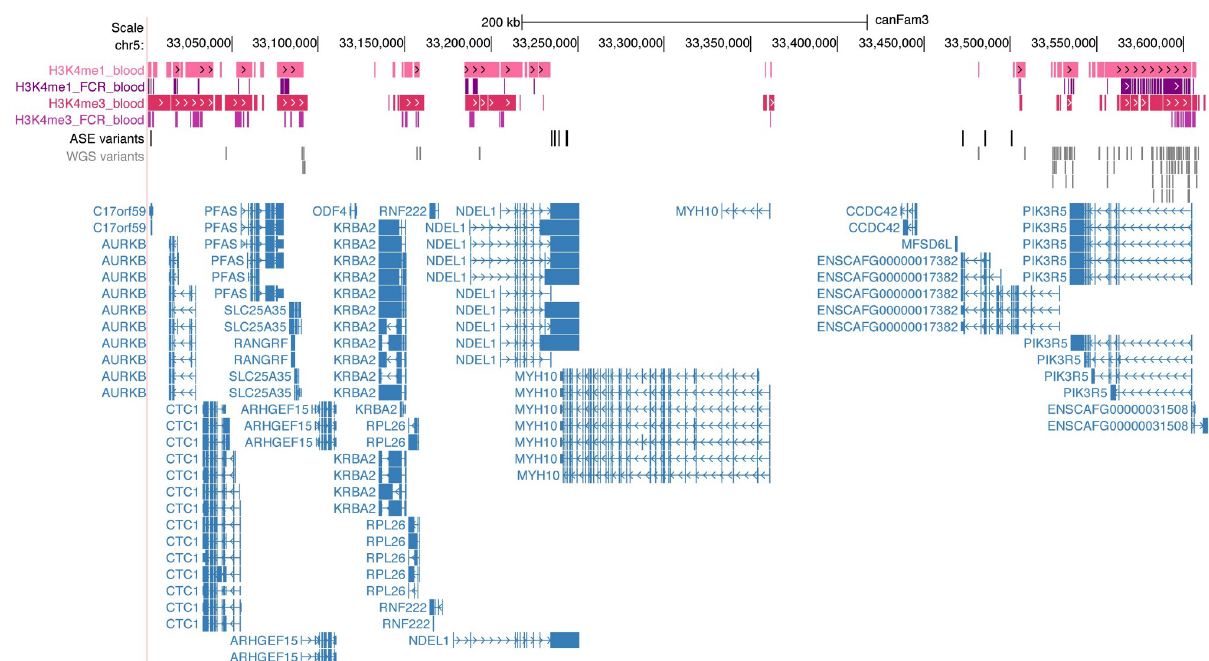
Fig 5. Multi-omics variant analysis. UCSC CanFam3.1 tracks at the 631 kb shared risk haplotype show the blood ChIP-seq regions for H3K4me1 and H3K4me3 for Bernese mountain dogs (pink) and the FCR (purple). ASE variants (black), 98 WGS variants meeting filtering criteria (gray), and the genes in the region are shown below ( ENSCAF00000017382 = PIK3R6 ).